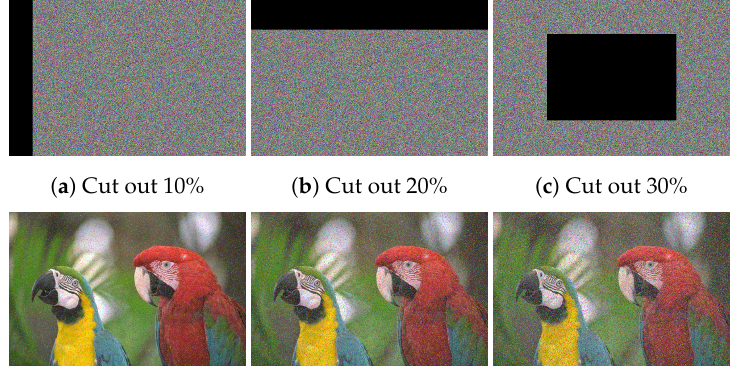
Figure 18. Outcomes of data loss attack, in which the top row refers to the defective Cipher–Macaws image by performing a cutting block for data with various sizes, while the bottom row represents the corresponding decipher